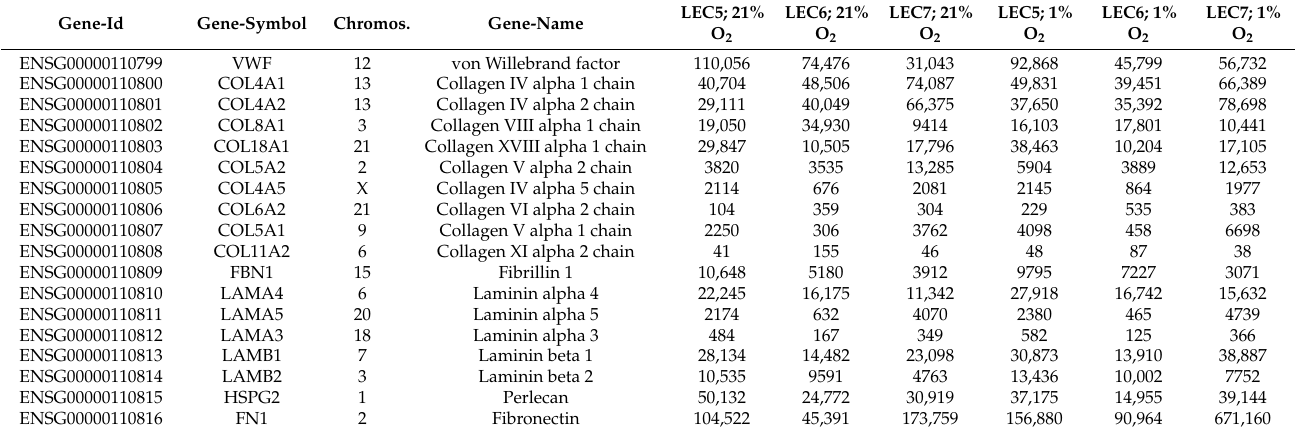
Table 3. List of ECM genes highly expressed in LECs in vitro. Number of reads in all samples (Human Dermal-LEC5,6,7) is shown under normoxia (21% O 2 ) and hypoxia (1% O 2 ). Note expression of typical basal lamina components, which are not significantly up- or down-regulated by